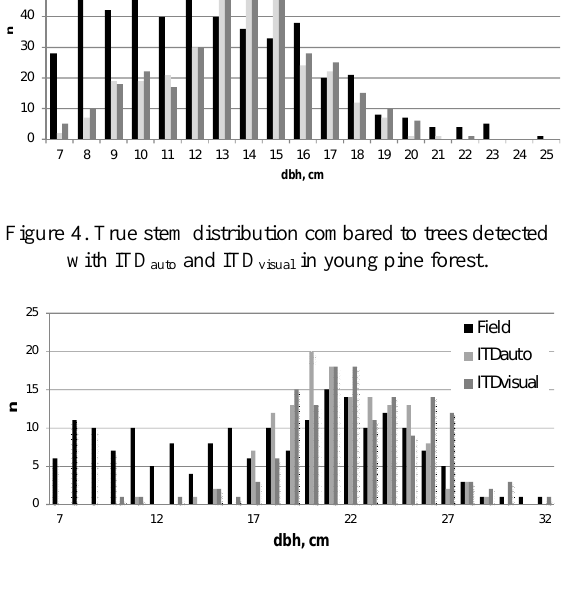
Figure 5. True stem distribution compared to trees detected with ITD auto and ITD visual in mature pine forest.